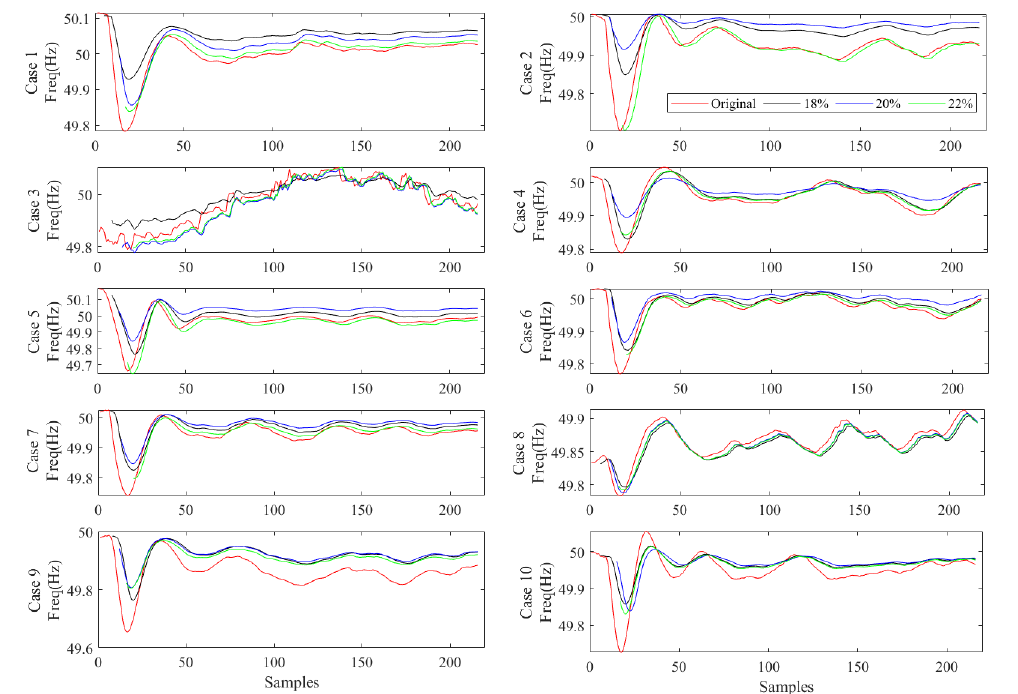
Figure 15. Results for the LSTM models in all Sweden cases.